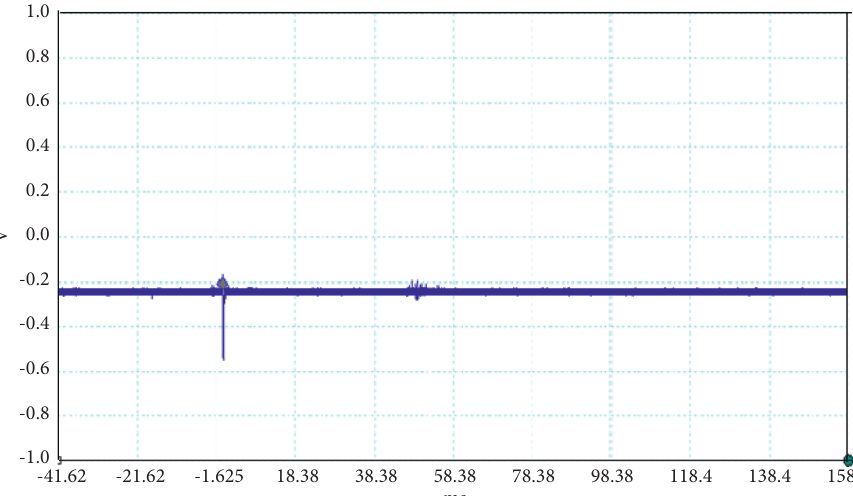
Figure 5: Example of the unusual lightning signal of window size 200ms, which is recorded as a flash number 20150416-0065 in Kathmandu, Nepal.